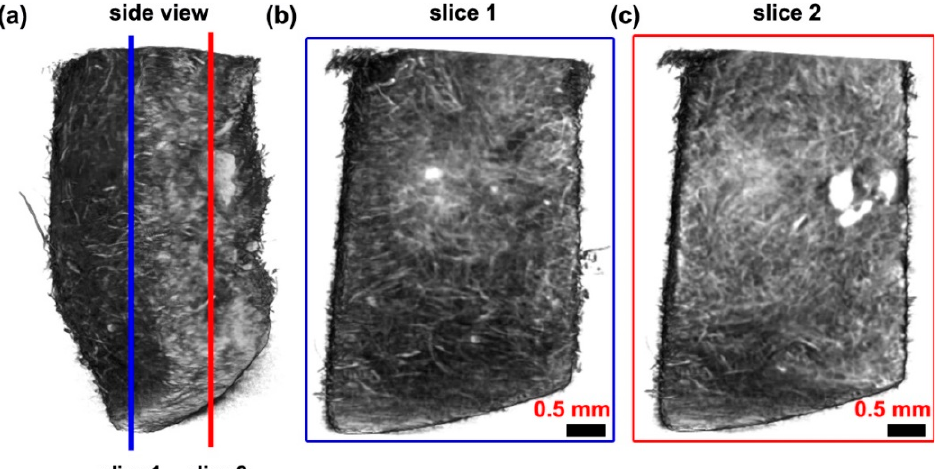
Figure 5. Two representative virtual slices with a thickness of 6.5 µm showing the interior aggregates: (a) 3D morphology of the yttria-stabilized ZrO 2 fiber insulation tile at a side view, (b) virtual slice 1 in blue, and (c) virtual slice 2 in red.